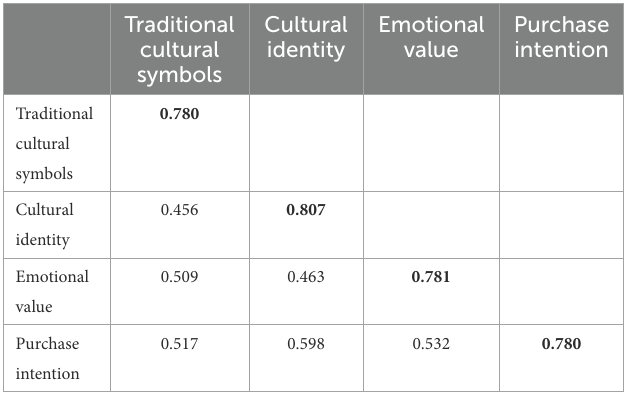
TABLE 4 Discriminant